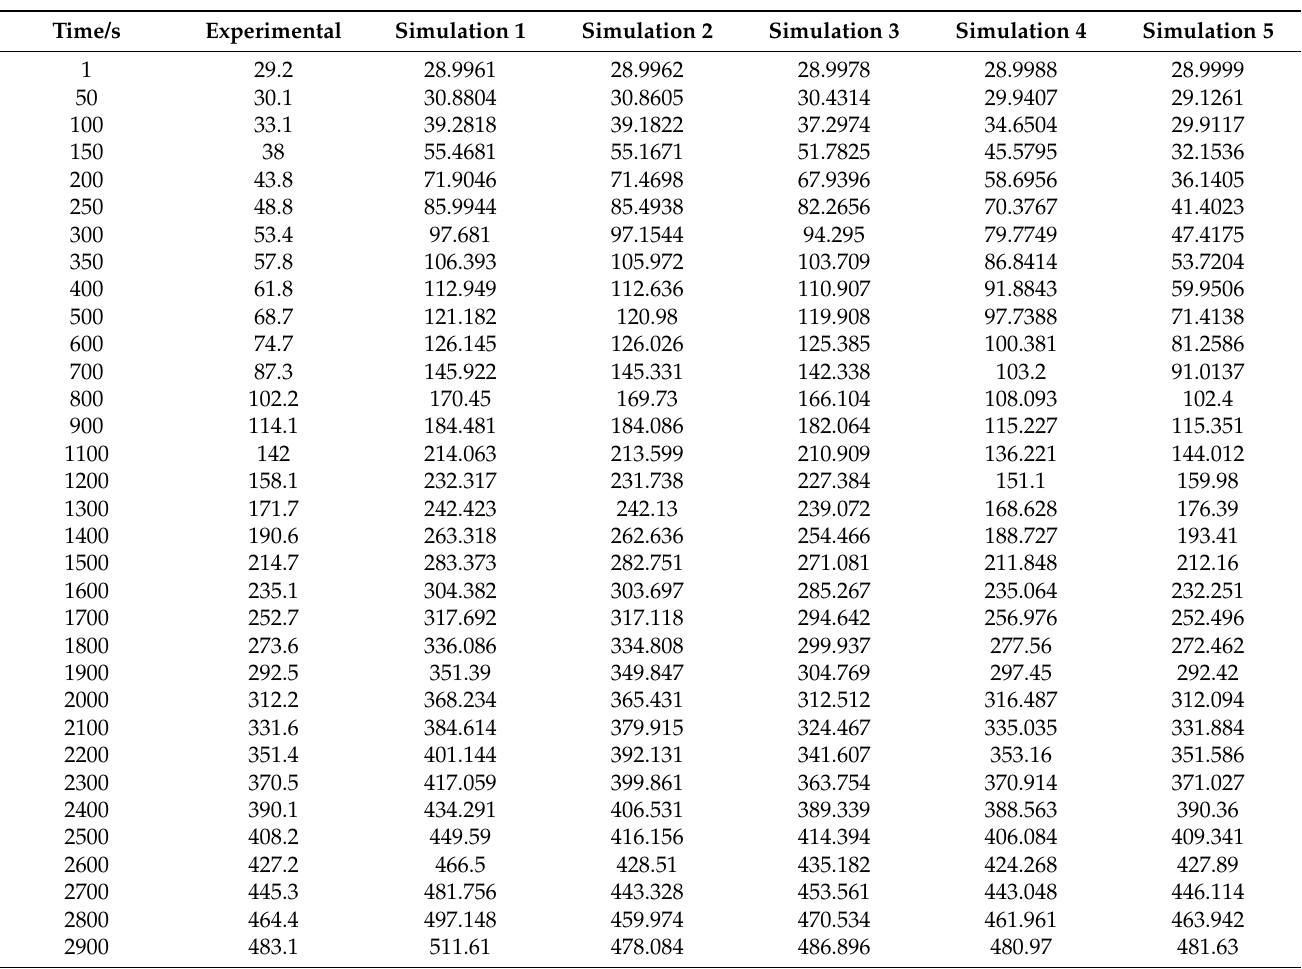
Table 5. The temperature data of the heating